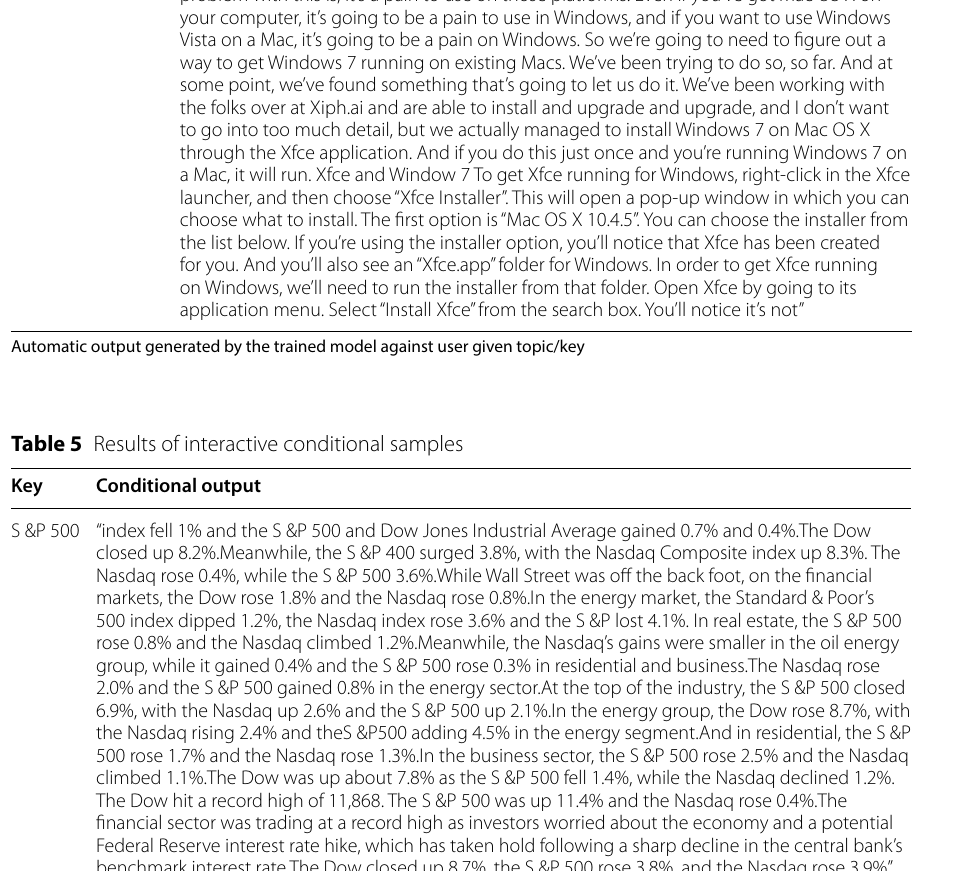
Automatic output generated by the trained model against user given topic/key